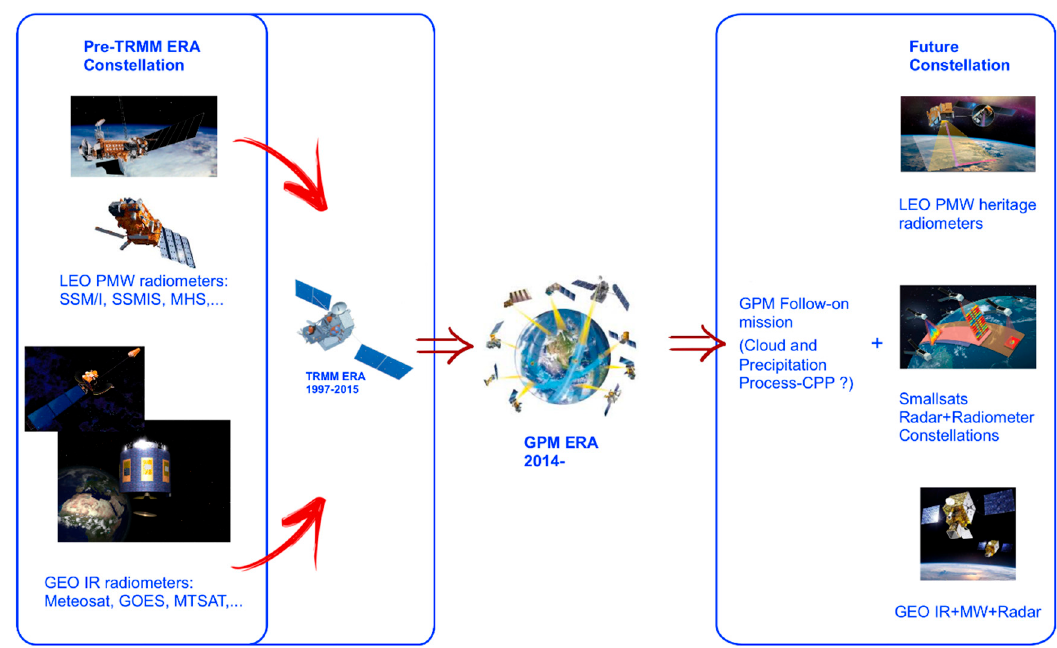
Figure 5. Evolution of the satellite constellation for precipitation measurements.